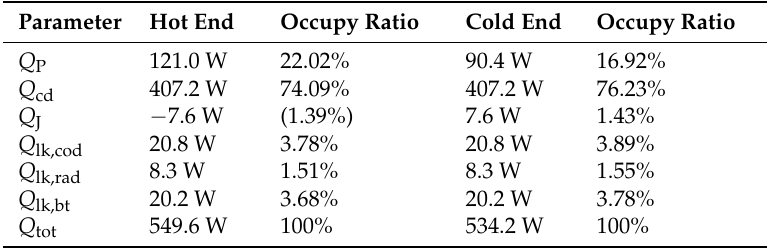
Table 5. Heat fluxes from the hot end and to the cold